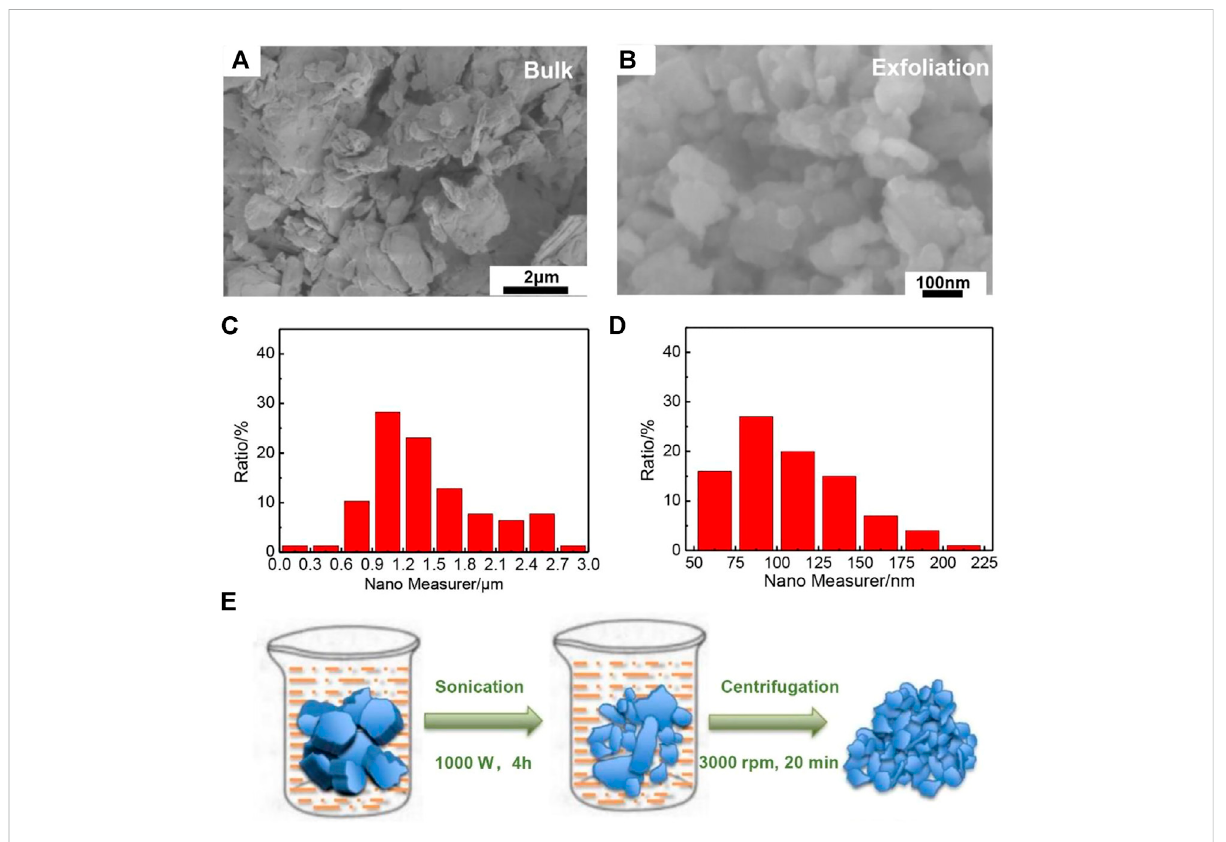
FIGURE 3 Comparison of the morphology for bulk and exfoliated MnPSe 3 . (A,B) The SEM images of MnPSe 3 nano fl akes by hand grinding and exfoliation. (C,D) The size distribution of bulk and exfoliated MnPSe 3 nano fl akes corresponds to Figures 3A,B. (E) The processing illustration of MnPSe 3 nano fl akes was obtained by sonication-assisted